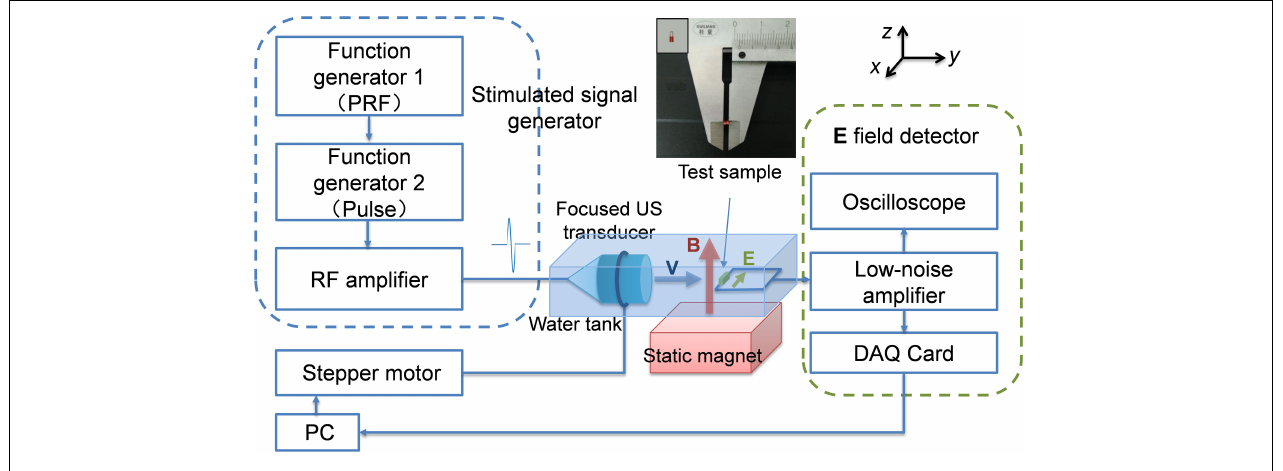
FIGURE 1 | E-field distribution detection system for TMAS.